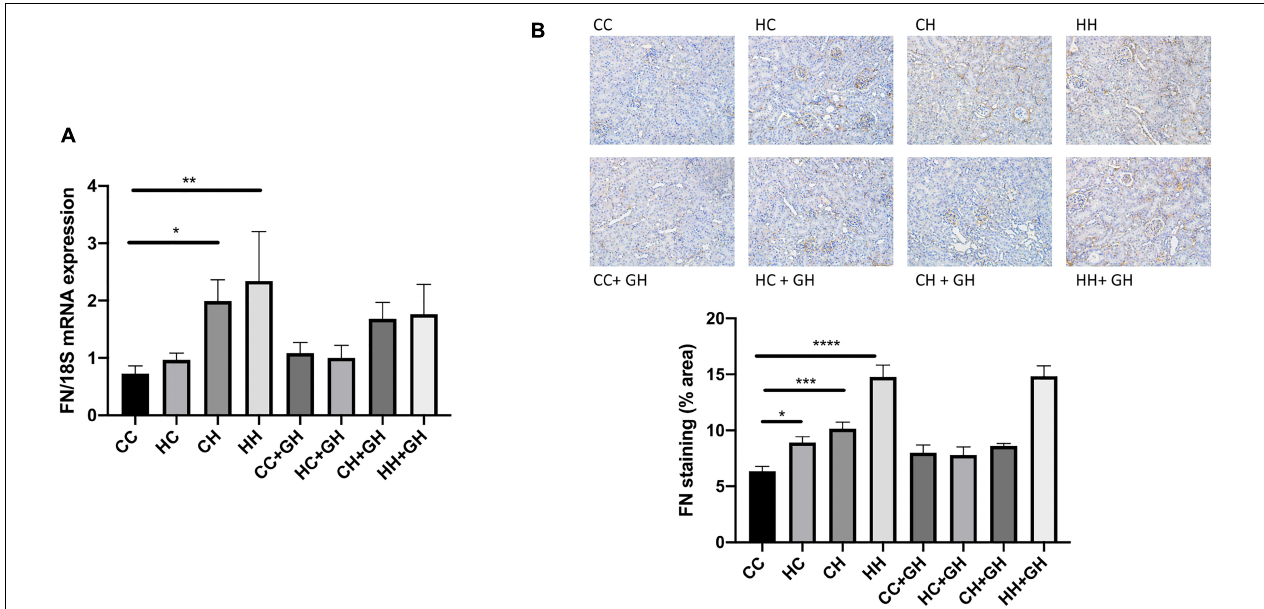
FIGURE 6 | Renal fibrotic changes as measured by fibronectin. (A) mRNA expression of fibronectin, (B) representative images of fibronectin staining at 200 × magnification, and quantitation. Results expressed as mean ± SEM, n = 6. * p < 0.05, ** p < 0.01, *** p < 0.001, **** p < 0.0001. CC, control offspring; HC, lean offspring of obese mothers; CH, obese offspring of lean mothers; HH, obese offspring of obese mothers; CC + GH, control offspring exposed to gestational hydralazine; HC + GH, lean offspring of obese mothers with gestational hydralazine; CH + GH, obese offspring of lean mothers with gestational hydralazine; HH + GH, obese offspring of obese mothers with gestational hydralazine.